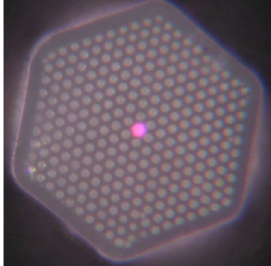
Figure 4. End-face of the liquid crystal infiltrated PCF for the measurement of temperature and electric fields (Reproduced from [40], with the permission of IOP science publishing).